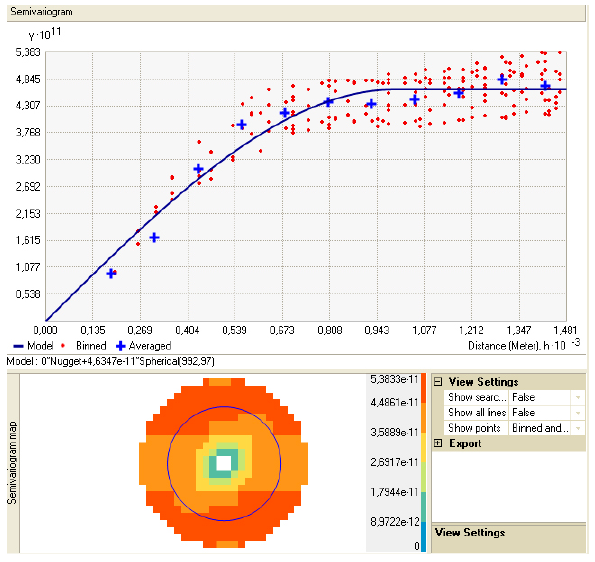
Fig. 5. Semivariogram – spatial structure of the trend value Source : own study.